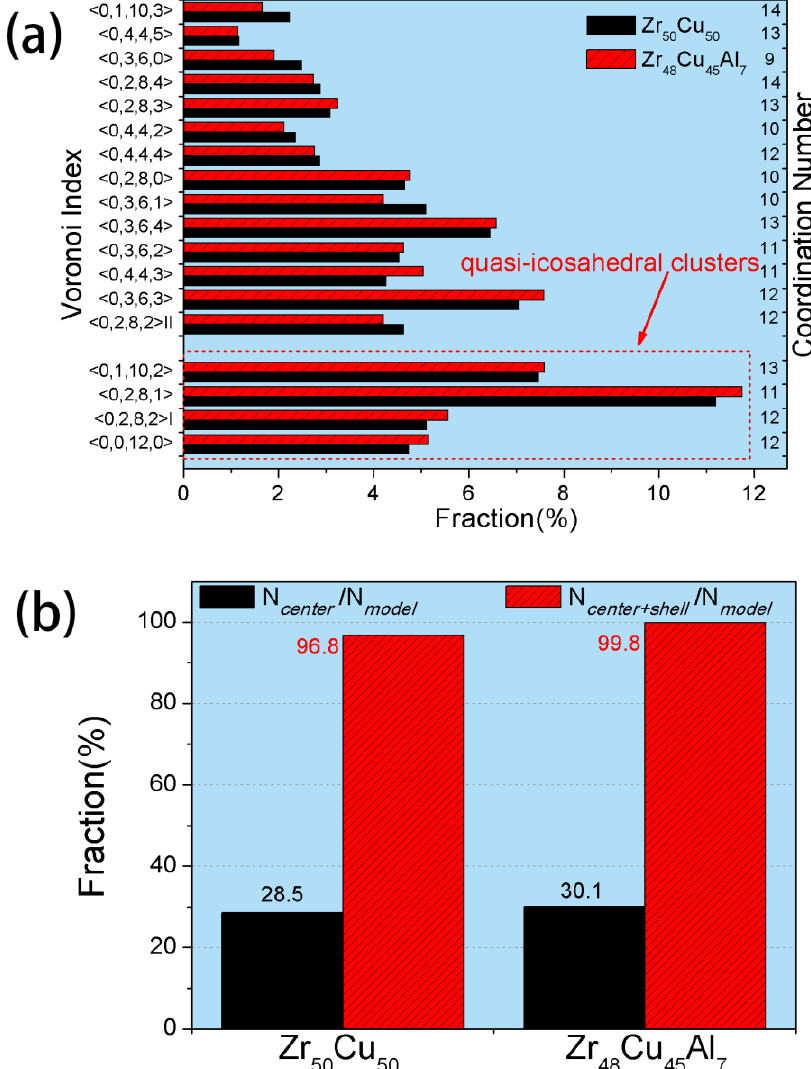
Figure 4. ( a ) Distribution of major Voronoi clusters; ( b ) the proportions of center atoms (center and shell atoms) in all the quasi-icosahedral clusters in the structural model. N center is the number of center atoms in the quasi-icosahedral clusters, N center + shell is the total number of atoms contained in the quasi-icosahedral clusters and N model is the total number of atoms in the structural model.